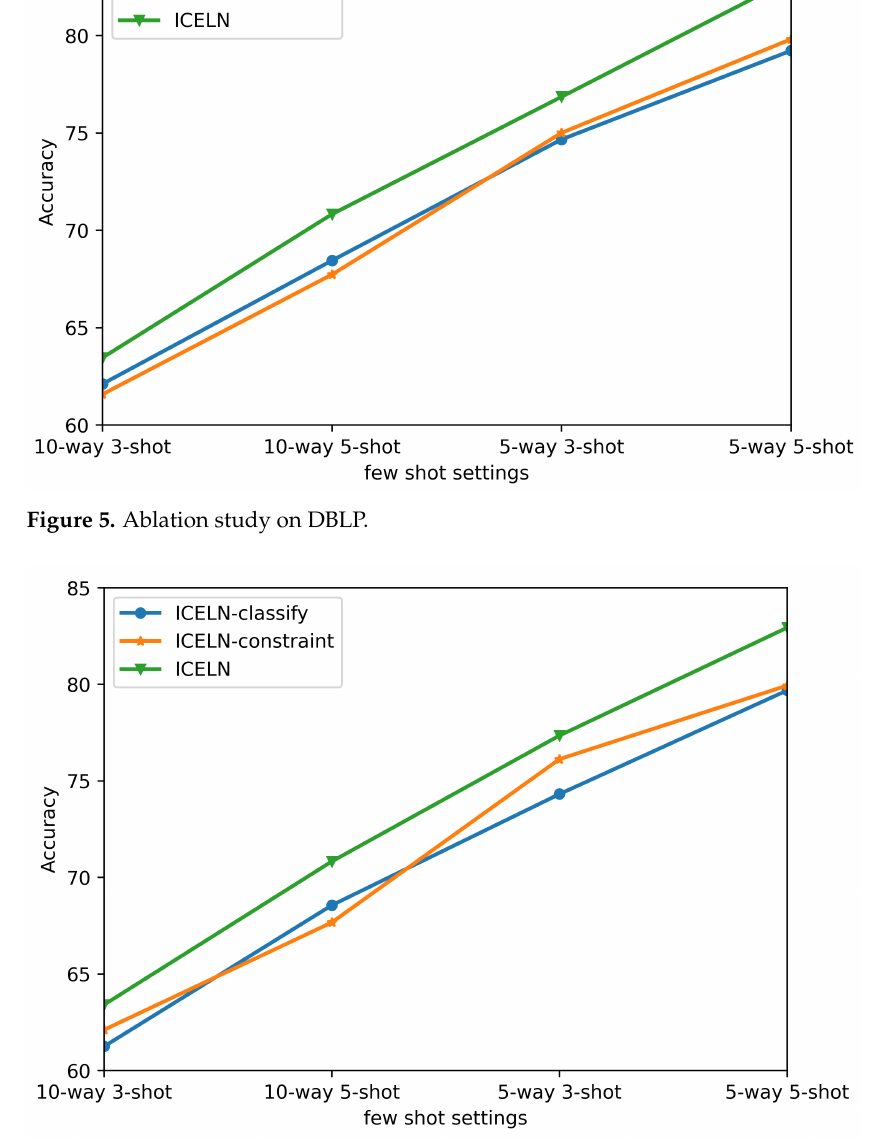
Figure 6. Ablation study on